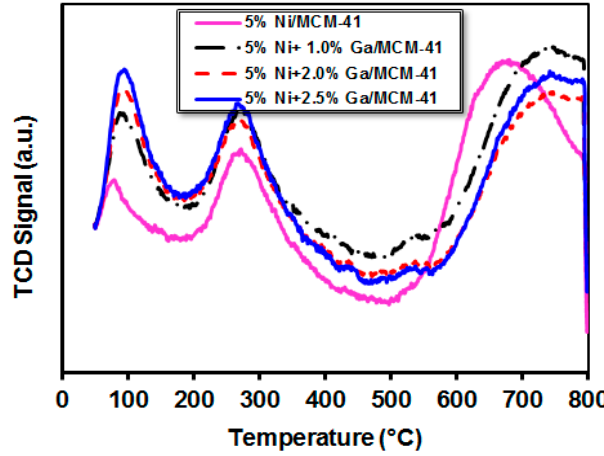
Figure 4. CO 2 -TPD profiles of 5%Ni+x%Ga/MCM-41. (x = 1.0, 2.0, 2.5). Table 2. Amount of CO 2 desorbed with respect to the peaks.